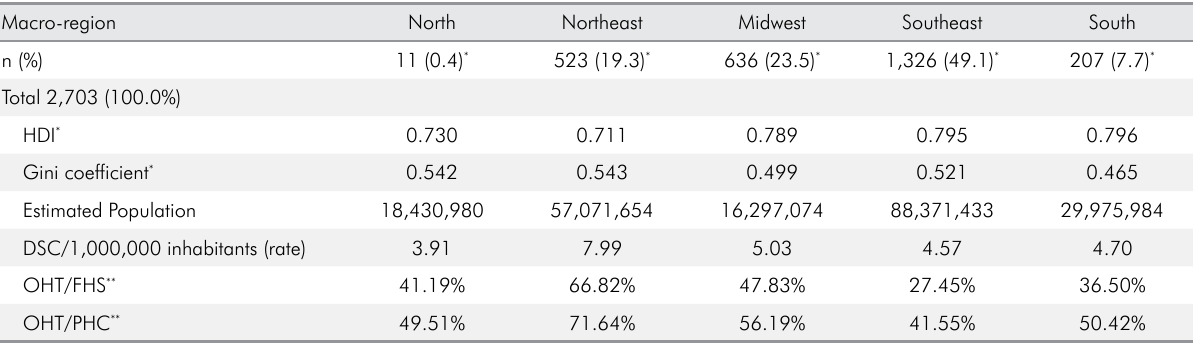
Table 1. Socioeconomic analysis of the Brazilian regions concerning the demand for teleconsulting. Brazil, 2019. Macro-region North Northeast Midwest Southeast South